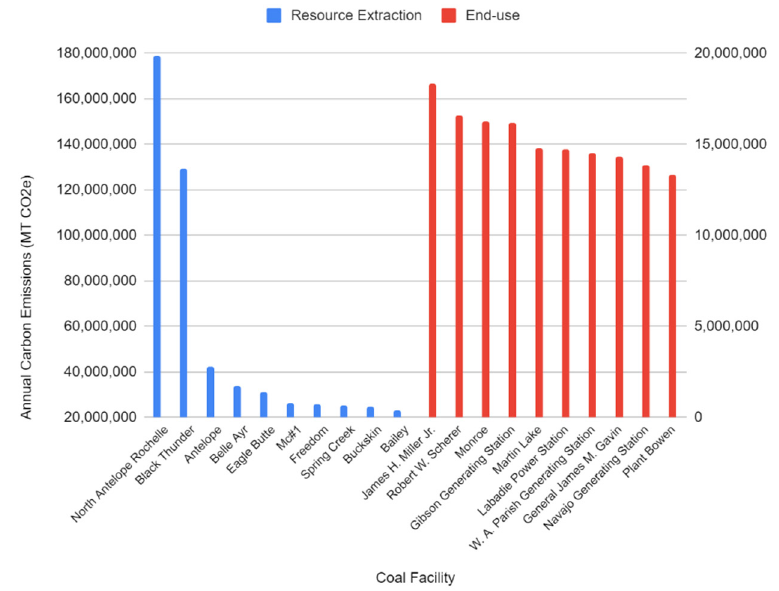
Figure 4. Top CO 2 Emission Point-Sources of the Coal Industry for Resource Extraction and End-use.